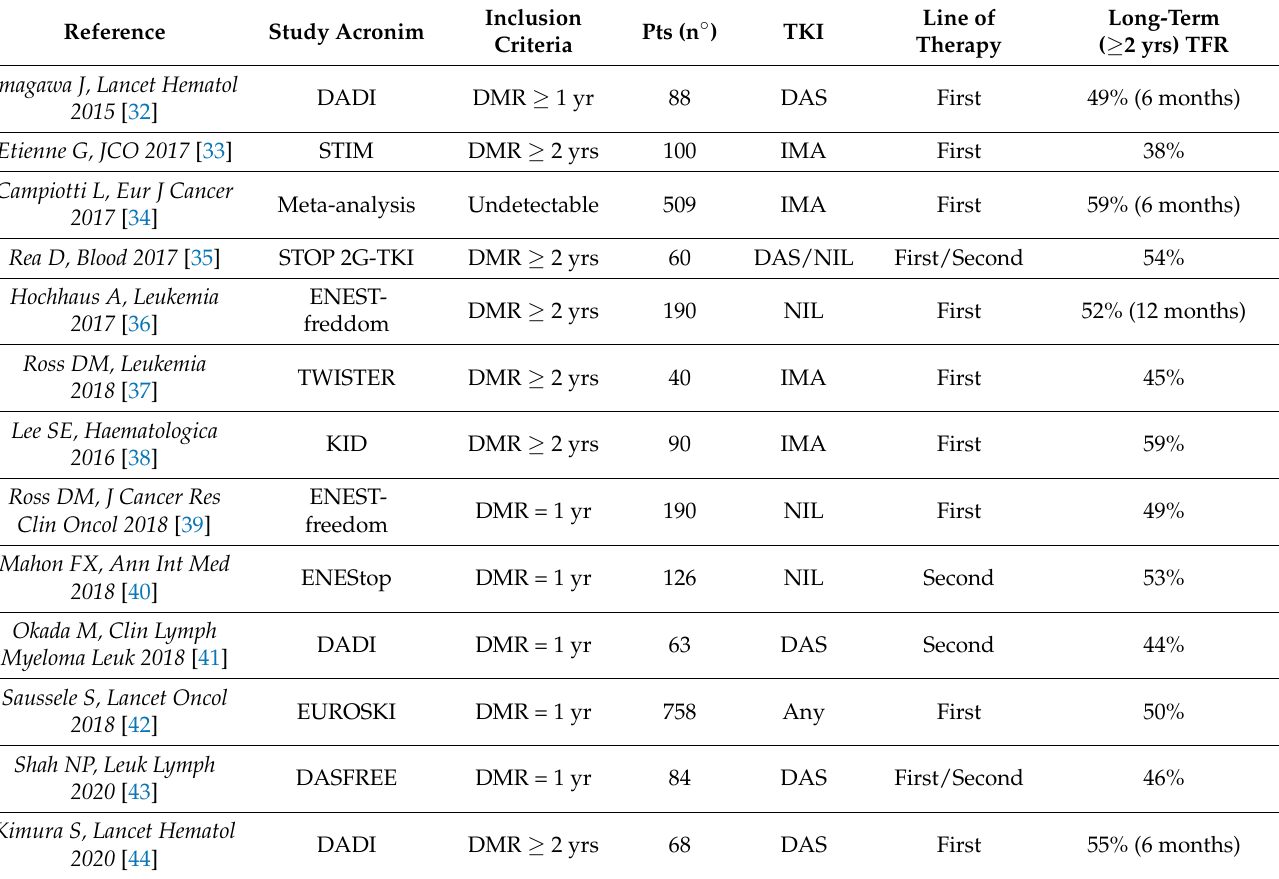
Table 1. Clinical trials investigating TFR in Ph+-CML